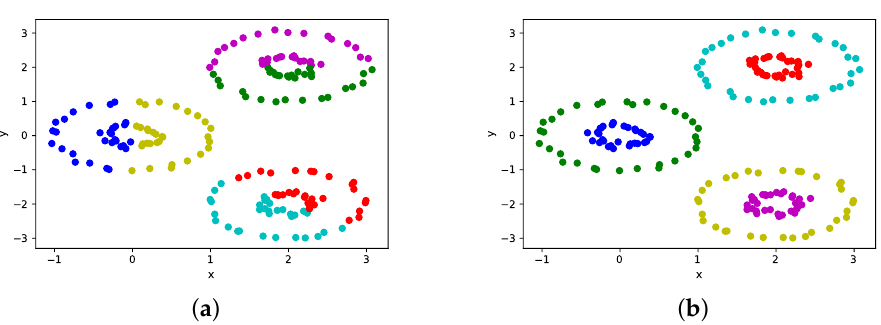
Figure 6. The clustering results on the dataset with 6 circles. Data points having the same color belong to the same cluster. ( a ) The conventional Euclidean-based method; ( b ) the proposed kernel-based method.